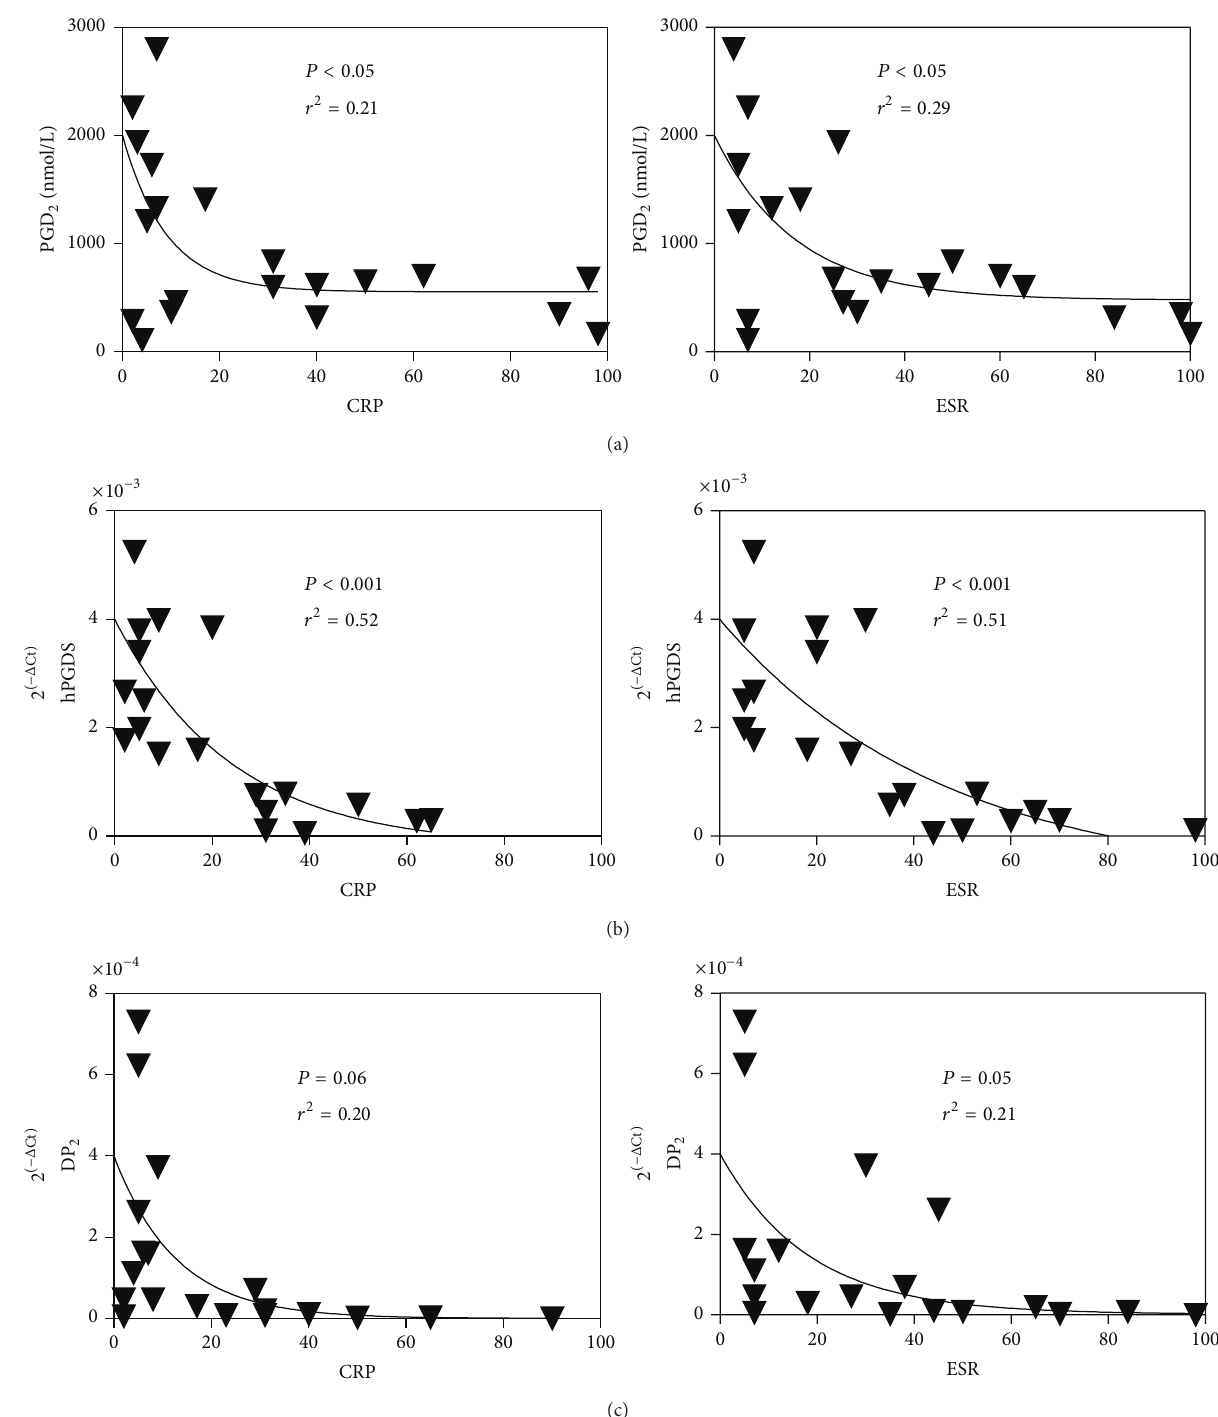
Figure 4: Pearson’s correlations between systemic disease activity measured by CRP or ESR and (a) synovial concentrations of PGD 2 , and synovial mDC expression of (b) hPGDS and (c) DP 2